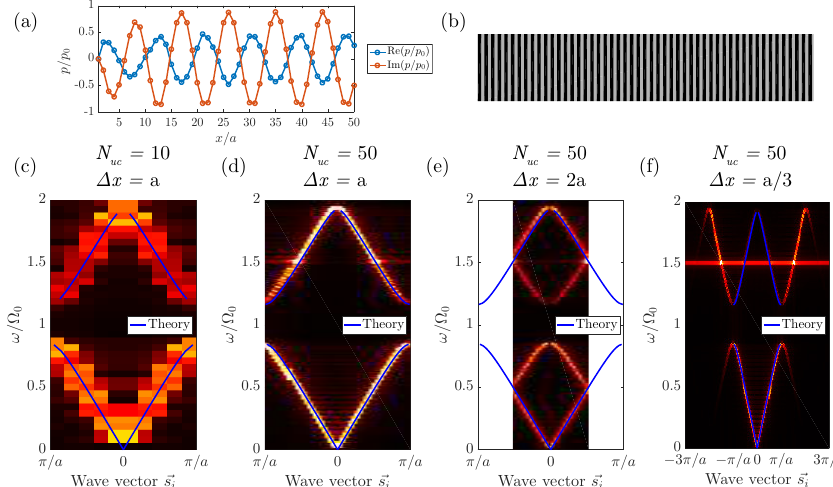
Figure 2. ( a ) Example of real and imaginary parts of the spatial pressure signal along the multilayer structure at the normalized frequency ω / Ω 0 = 0.25. ( b ) Periodic multilayer structure composed of N uc = 50 periodic elements, combining two artificial materials with different acoustic properties. ( c – f ) Double FT of the pressure field and dispersion relation of the multilayer structure considering different number of periodic elements and different values of the spatial sampling ∆ x